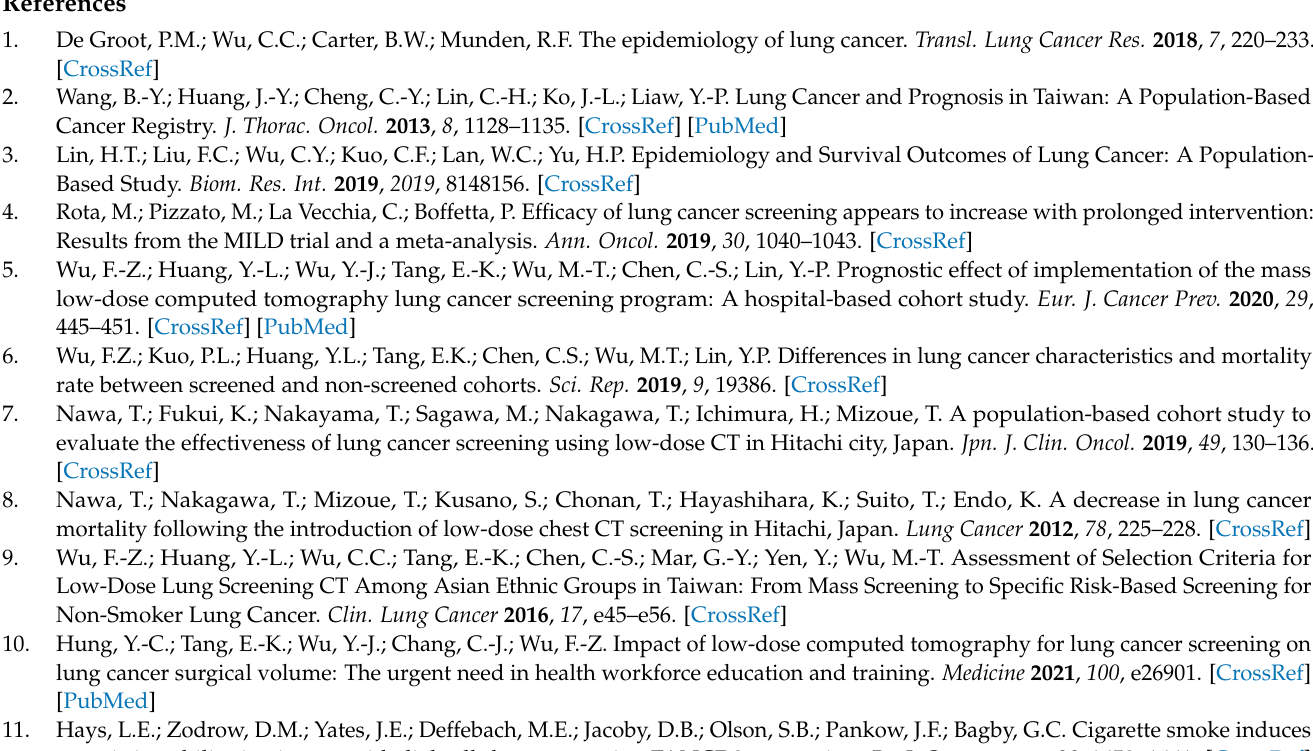
according to screening status, Table S2: Clinical characteristics of 1232 smokers with lung cancer